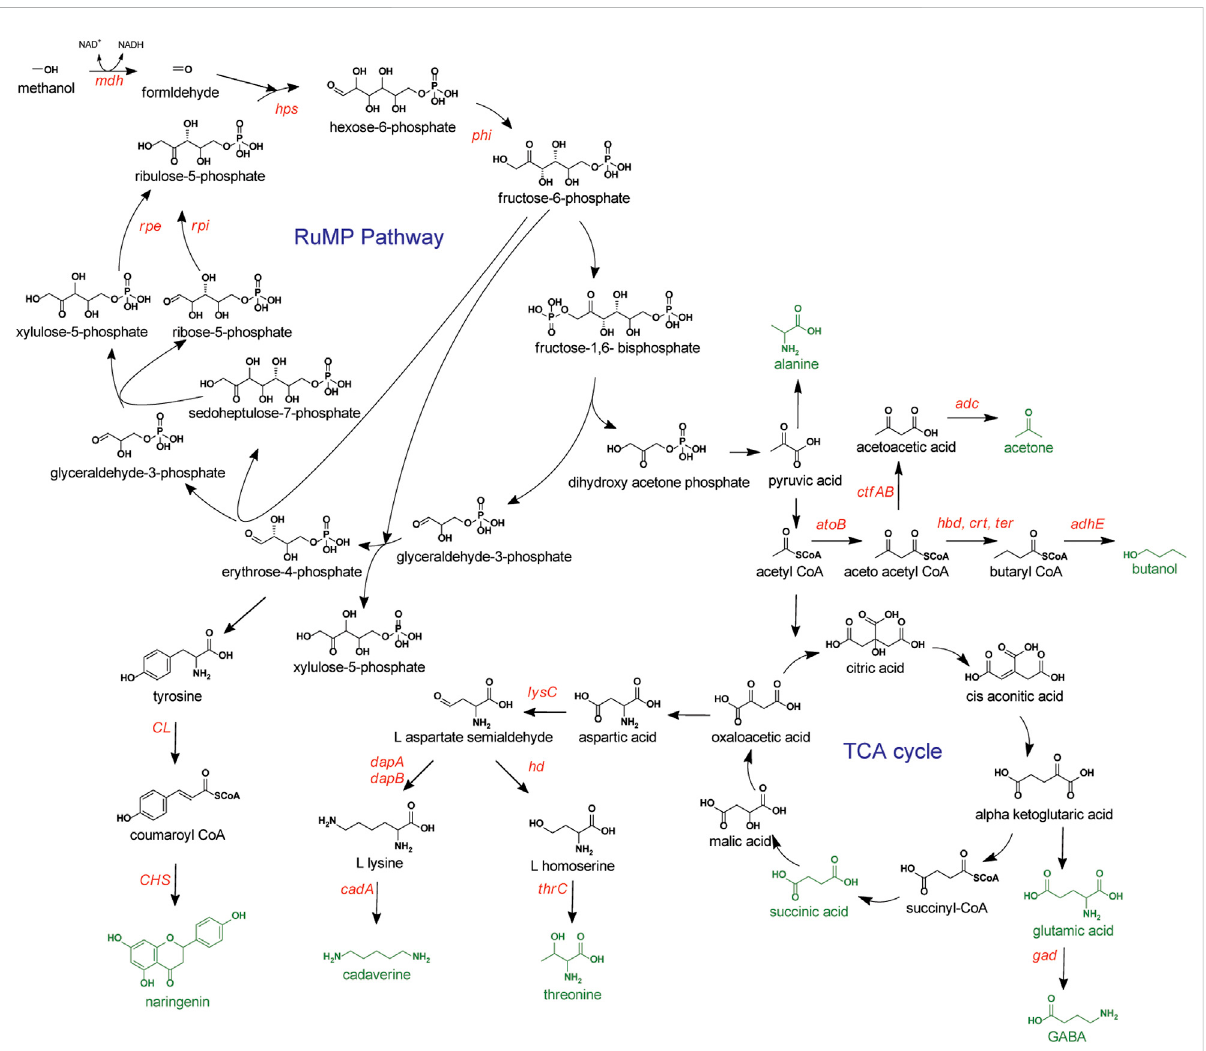
FIGURE 2 Methanol metabolism via RuMP pathway. Compounds targeted for production represented in green. Overexpressed genes or enzymes are presented in red. GABA, gama-aminobutyric acid; Aox, alcohol oxidase; hps, hexulose-6-phosphate synthase; phi, 6-phospho-3-hexuloisomerase; rpe, ribose 5-phosphate epimerase; rpi, ribose 5-phosphate isomerase; CL, 4-coumaroyl CoA ligase; CHS, chalcone synthase; lysC, aspartokinase; dapAB, dihydrodipicolinate synthase and reductase; cadA, L-lysine decarboxylase; hd, homoserine dehydrogenase; thrC, threonine synthase; atoB, acetyl-CoA acetyltransferase; adc, acetoacetate decarboxylase; ctfAB, coenzyme A transferase; hbd, 3-hydroxylbutyryl-CoA dehydrogenase; crt, crotonase; ter, trans -2-enoyl-CoA reductase; adhE, aldehyde/alcohol dehydrogenase; gad, glutamate